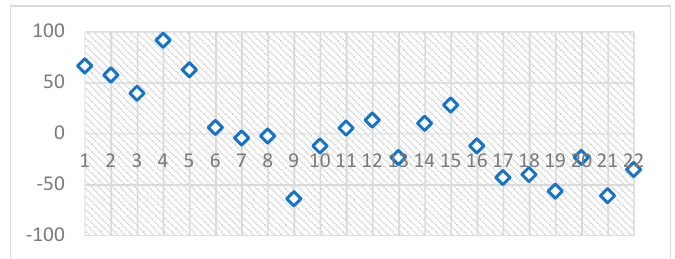
Figure 6. Tehran municipal districts’ resilience score.